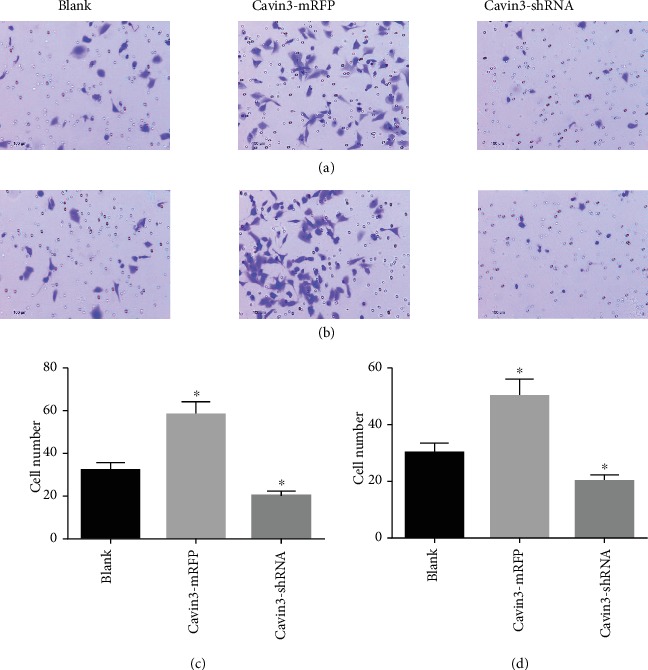
Effects of Cavin3 expression on the cell invasion and migration in lung cancer. Images of (a) cell migration and (b) invasion in each transfected group and (c: migration, d: invasion) corresponding histograms (∗ means p < 0.05, N = 3).